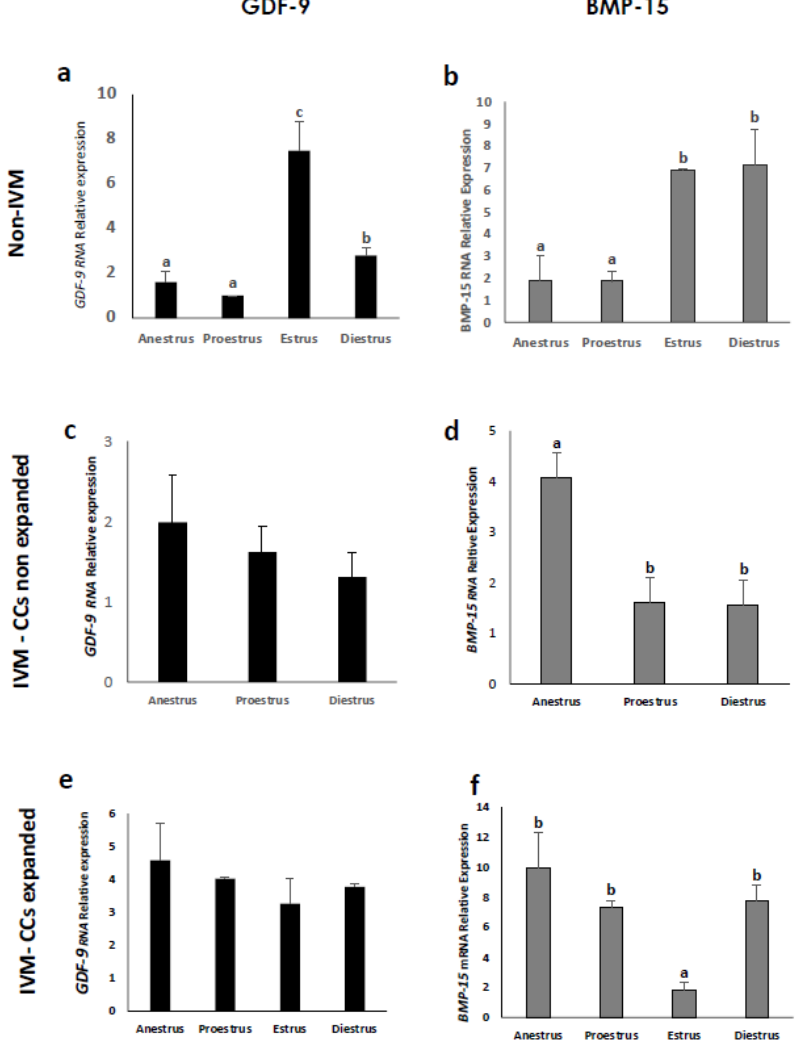
Figure 3. Relative gene expression of Growth Di ff erentiation Factor 9 ( GDF-9 ) and Bone Morphogenetic Protein 15 ( BMP-15 ) from cumulus cells of nonmatured COCs ( a , b ) (~350 COCs at each phase of the estrous cycle), in vitro-matured non-expanded COCs ( c , d ) (~300 COCs at anestrus, proestrus and diestrus), and in vitro-matured expanded cumulus cells ( e , f ) (~300 at each phase). The mRNA levels were expressed in relation to β -Actin mRNA as the control or housekeeping gene. Di ff erent letters above the bars indicate differences at p < 0.05. Comparing gene expression between CCs retrieved from non-cultured COCs and those from COCs after IVM, both expanded and nonexpanded (Figure 4), CCs surrounding IVM oocytes obtained